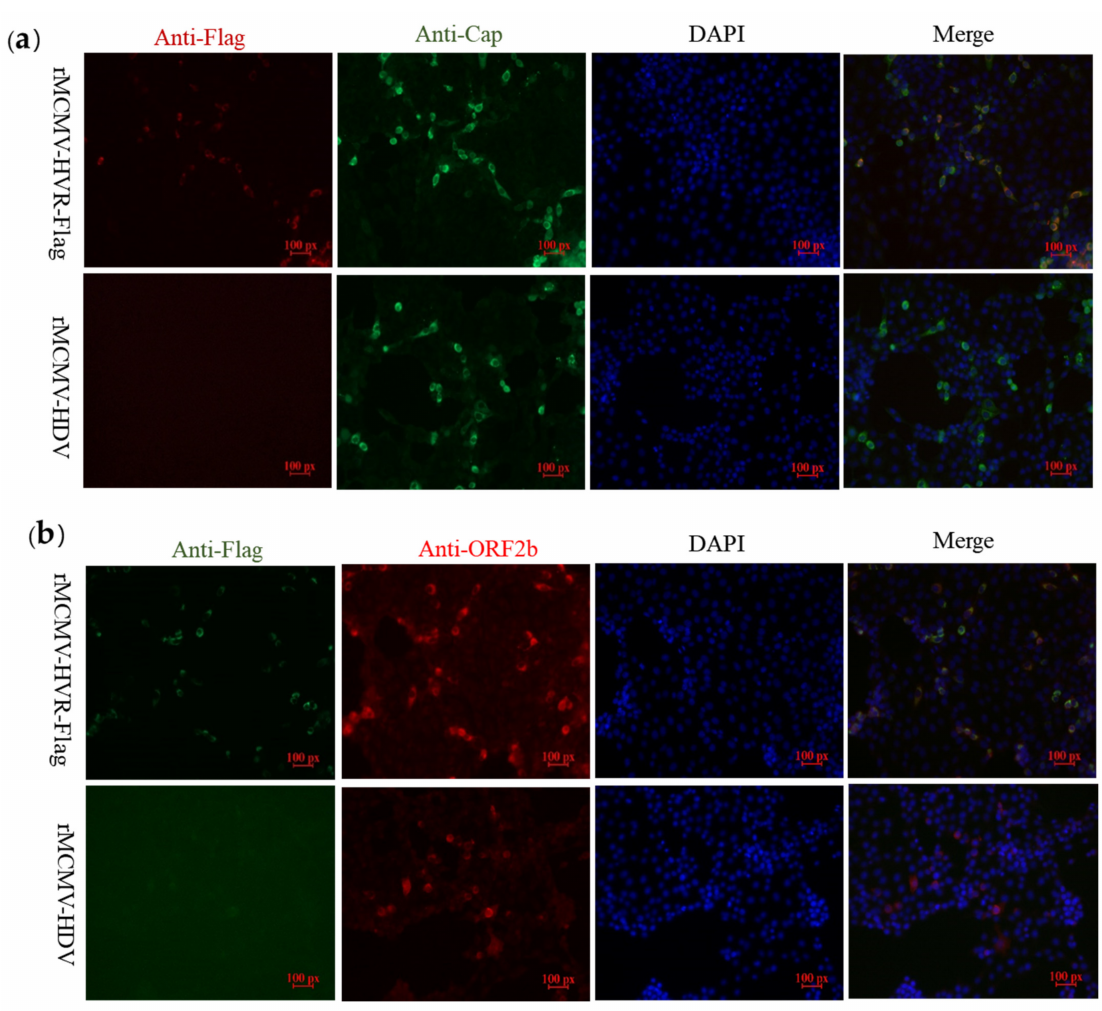
Figure 4. Flag-tagged ORF1a protein partially co-localizes with Cap and ORF2b proteins. ( a ) The PK-15 cells were infected with recombinant virus harboring Flag tag and parental viruses and subjected to immunofluorescence using a rabbit mAb against the Flag (red) and mouse mAb against capsid protein (green). ( b ) The PK-15 cells were subjected to immunofluorescence using a mouse mAb against the Flag (green) and a rabbit PcAb against the ORF2b protein (red). PK-15 cells were then stained with either goat anti-mouse IgG H&L (CoraLite488) or goat anti-rabbit IgG H&L (CoraLite594). The cell nuclei were counterstained with DAPI (blue) (magnification 20 ×